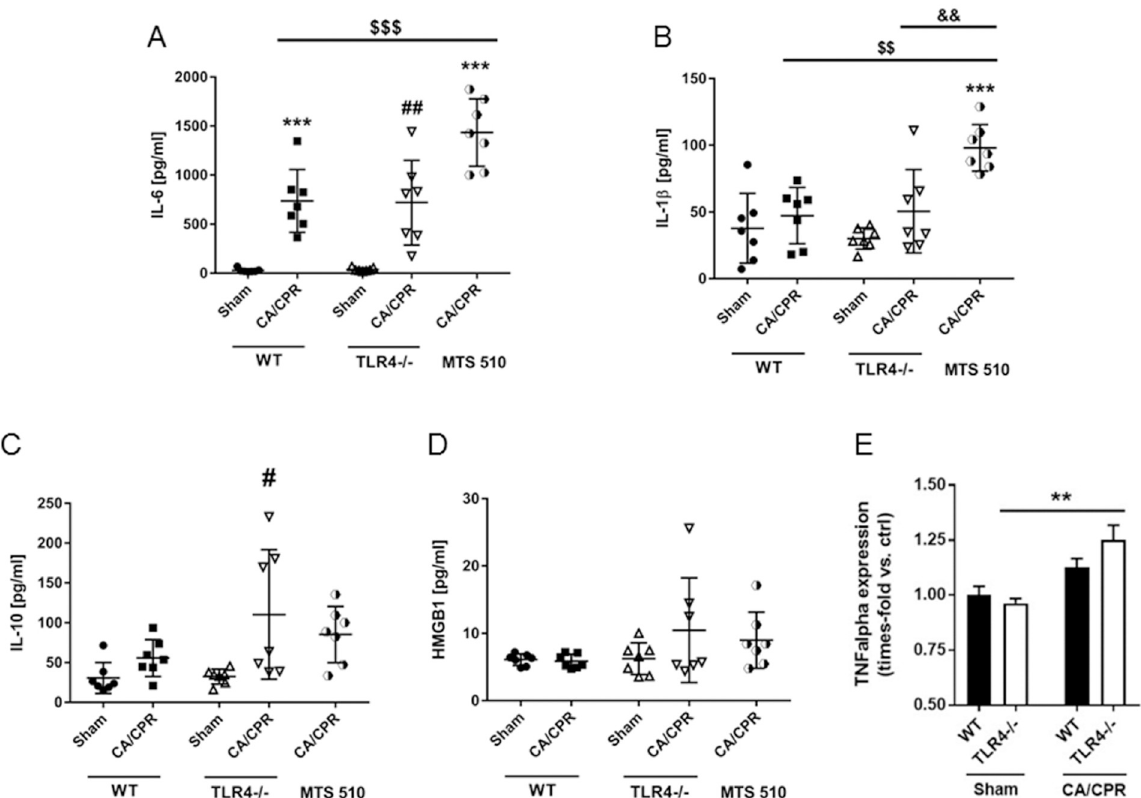
Fig 3. Cytokine plasma and cerebral TNFalpha levels 8h after CA/CPR. In separate sets of experiments, (A) interleukin-6 (IL-6), (B) interleukin-1 β (IL-1 β ), (C) interleukin-10 (IL-10), (D) high mobility group box 1 (HMGB1) plasma levels were assessed in wild type (WT), TLR4 -/- and mice treated with TLR4 blocking antibody MTS510.and (E) cerebral TNFalpha expression was analyzed in WT and TLR4 -/- mice. �� P < 0.01, ��� P < 0.001, #P < 0.05, ##P < 0.01, $ $P < 0.01, $ $ $P < 0.001 and &&P < 0.01 vs. WT sham control or as indicated. One-way ANOVA/